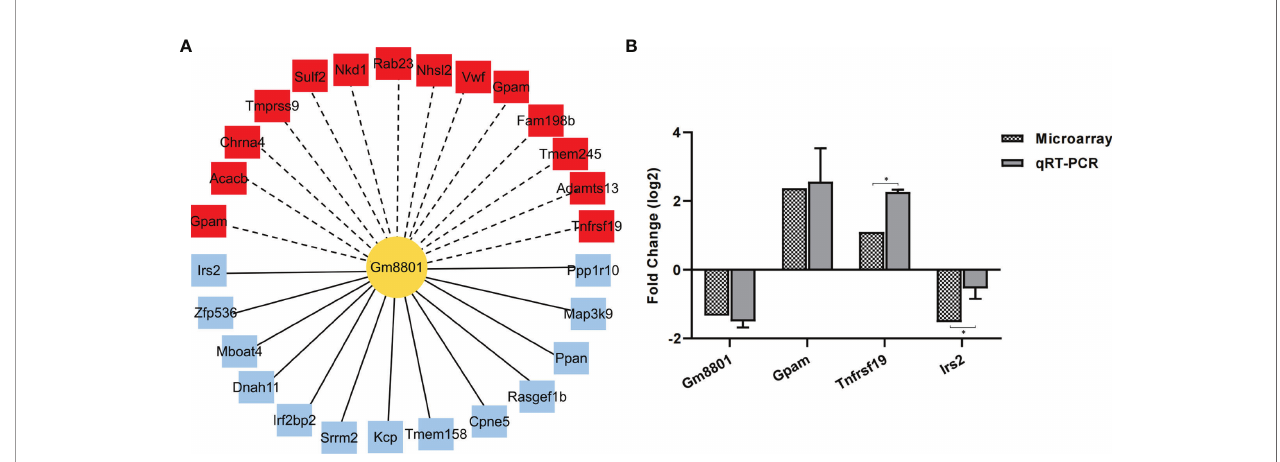
FIGURE 7 | The correlation between mRNAs and lncRNA Gm8801 . (A) The mRNAs correlated with Gm 8801 lncRNA. The red color indicates upregulation, while the blue color indicates downregulation. The solid lines mean positive correlation, and the dashed line means negative correlation. (B) The levels of mRNA Irs2 , Gpam , Tnfrsf19 , and lncRNA Gm8801 . *p <